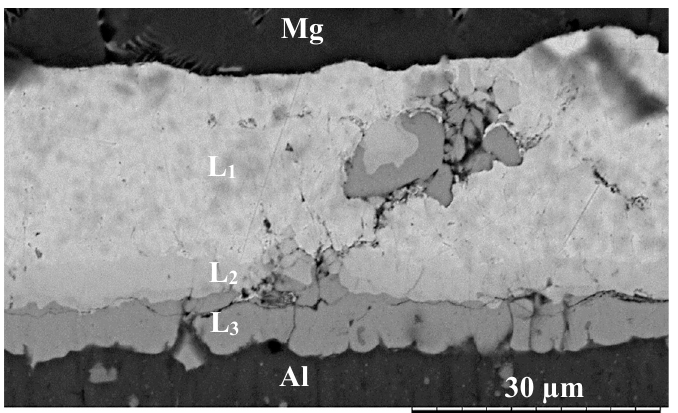
Figure 2. Scanning electron microscope (SEM) micrograph of the joint made using 20 µm Cu/Al 2 O 3 and bonded at 500 °C for 1 min.